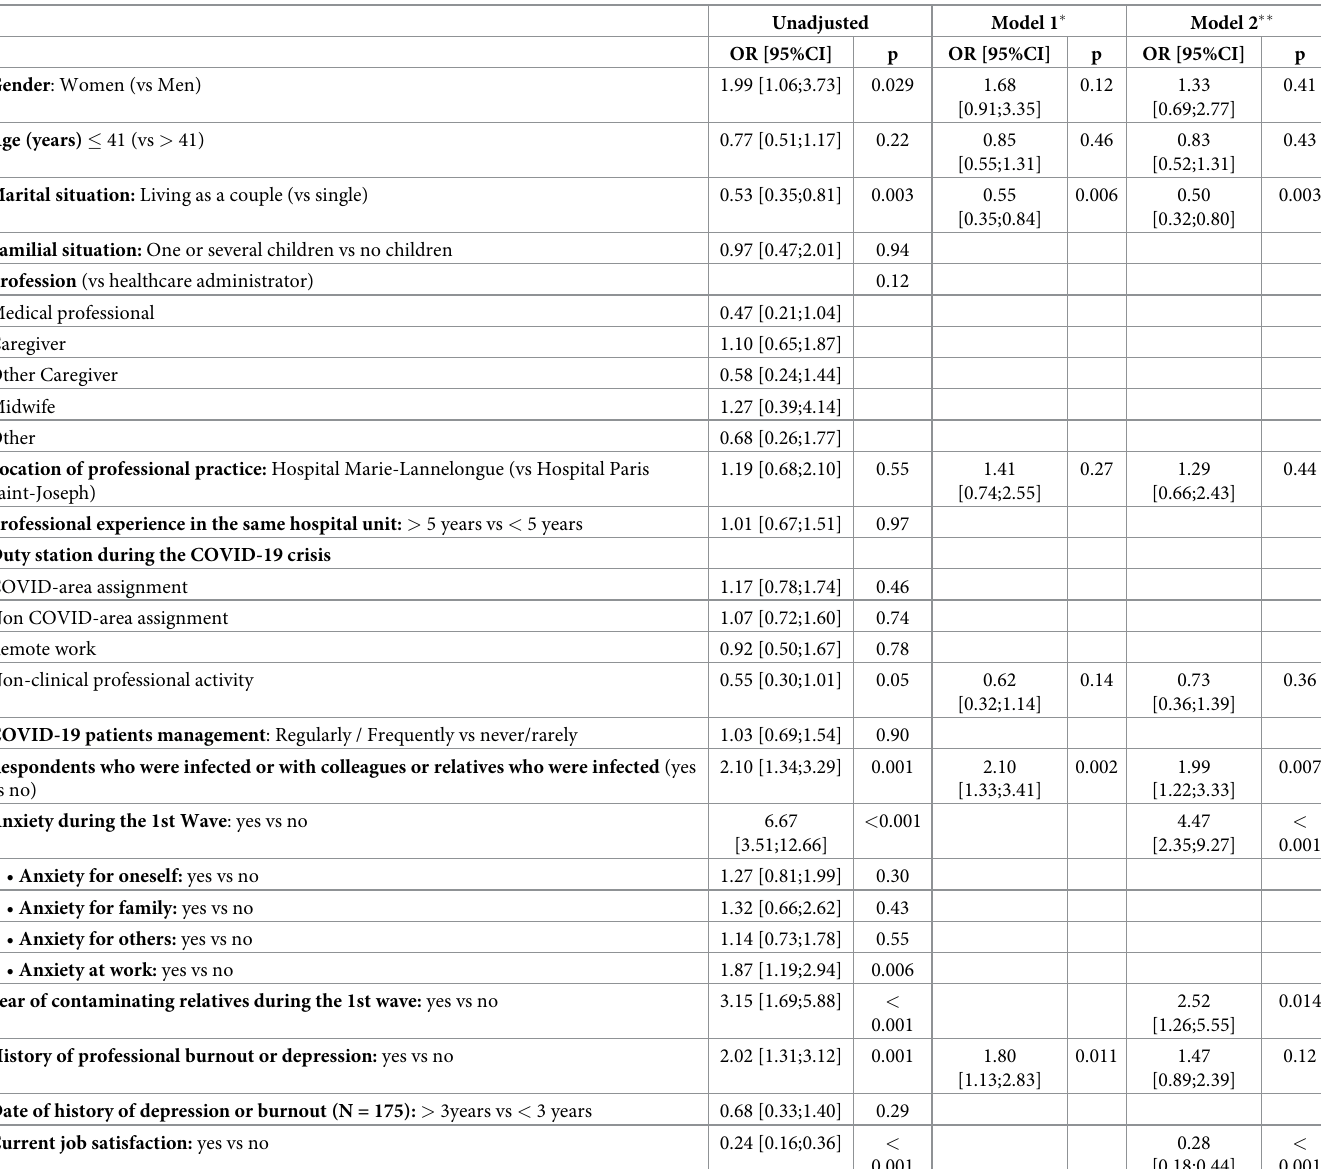
Table 4. Unadjusted and adjusted logistic regression for symptoms of post-traumatic stress (PCL > 44), n =